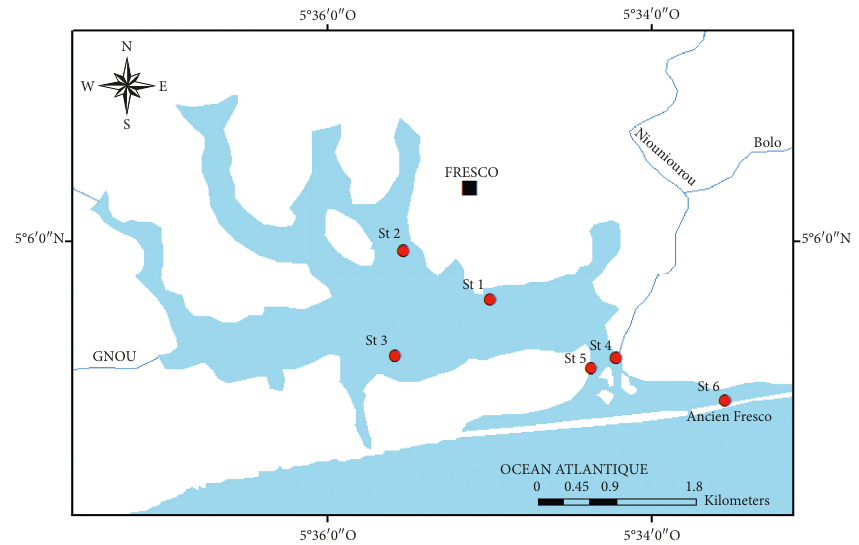
Figure 1: Map of Fresco lagoon showing water sampling sites. St: